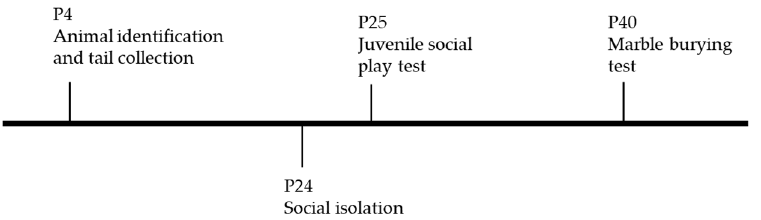
Figure 7. Timeline of behavioral experiments in this study. All animals were identified on postnatal day (P)4 with permanent tattoos on toes, and tails were collected for genotyping. On P24, animals were socially isolated in individual clean cages and juvenile social play test was carried out on P25.